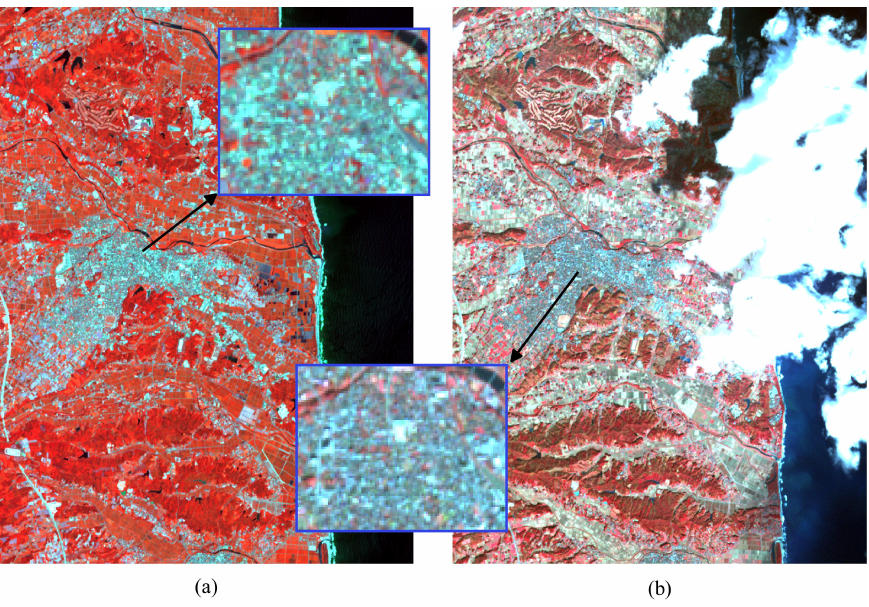
Figure 1. Two ASTER images taken on ( a ) July 2010 and ( b ) November 2010. Image ( a ) was taken in sunny conditions that caused much higher pixel values for urban area pixels (zoomed) than for image ( b ). For example, the value of the same pixel of this area is equal (83, 185, 126) for ( a ) and (37, 63, 81) for ( b ). Moreover, a great part of image ( b ) is covered by clouds and their shadow.